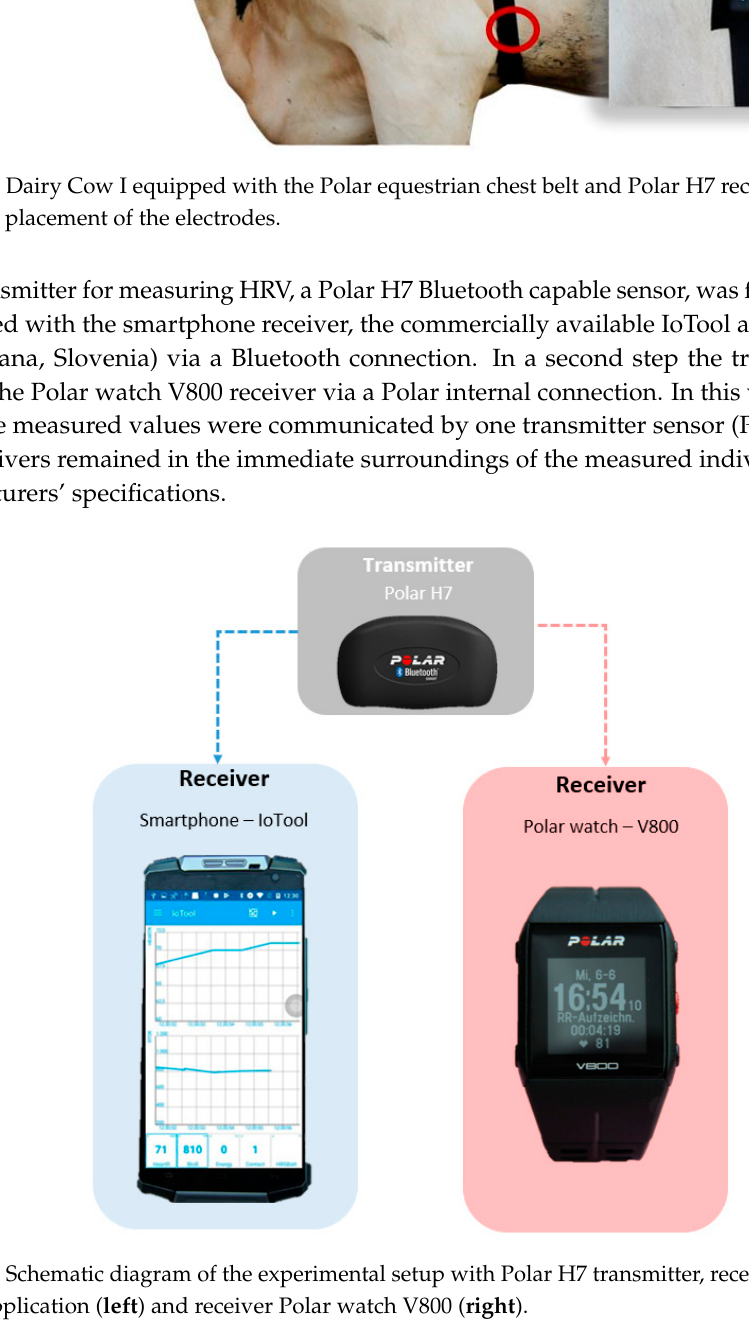
Figure 2. Schematic diagram of the experimental setup with Polar H7 transmitter, receiver smartphone IoTool application ( left ) and receiver Polar watch V800 ( right ).